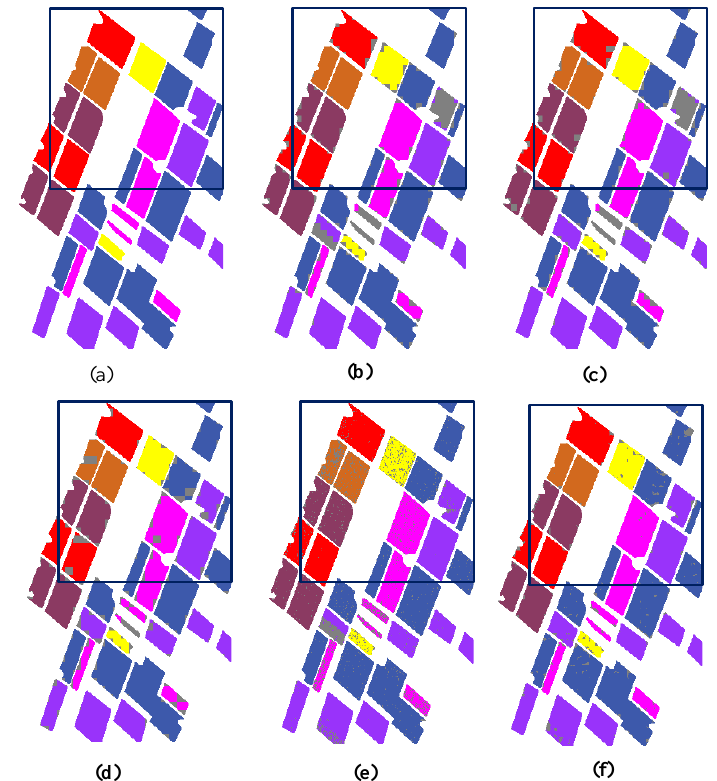
Figure 15. Results of different methods on Flevoland1991. ( a ) GT. ( b ) RV-CNN. ( c ) CV-CNN.